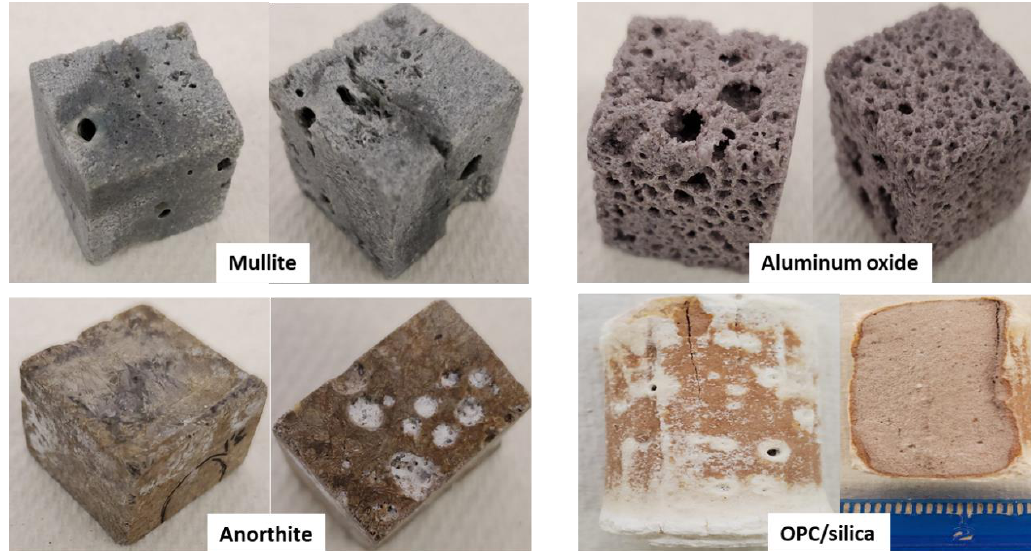
Figure 5. Appearance of samples after the 30-day, pH 1 sulfuric acid exposure.